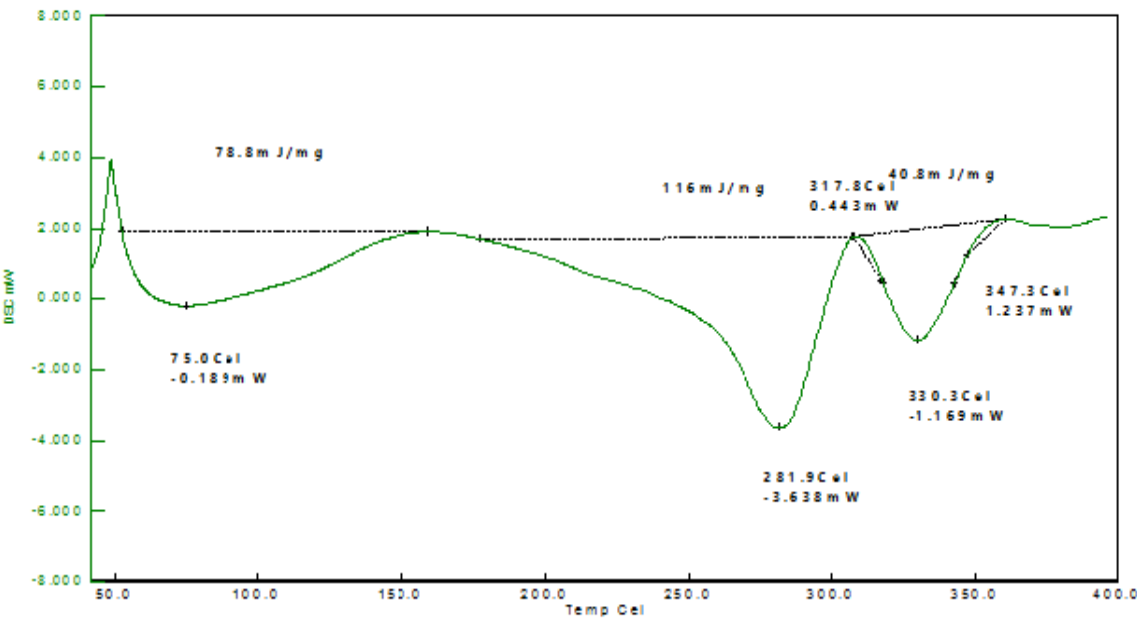
Figure 8. DSC spectrum of raltegravir